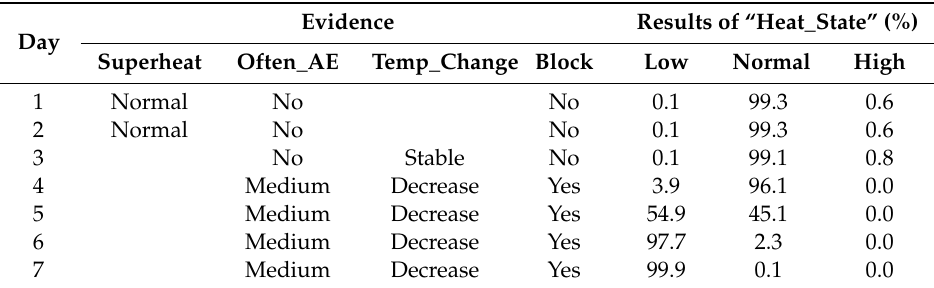
Table 6. Evidence and results of continuous calculation for Case